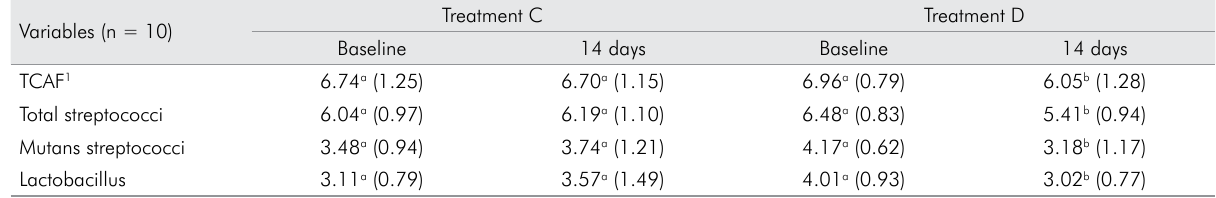
Table 4. Mean and standard deviation (SD) of microorganisms in saliva (log CFU/mL) at baseline and after 14 days (in vivo study). Variables (n =